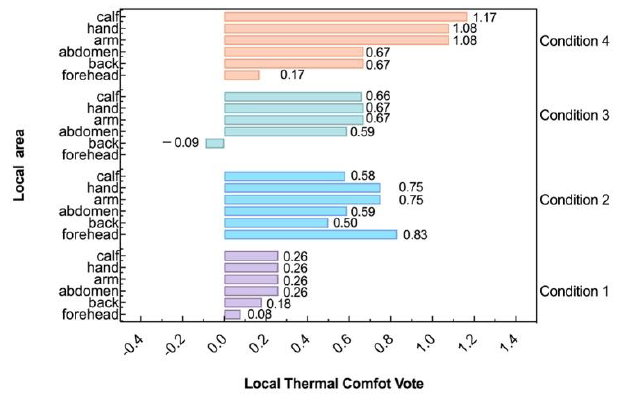
Figure 8. Local thermal comfort vote of young adults under different conditions.